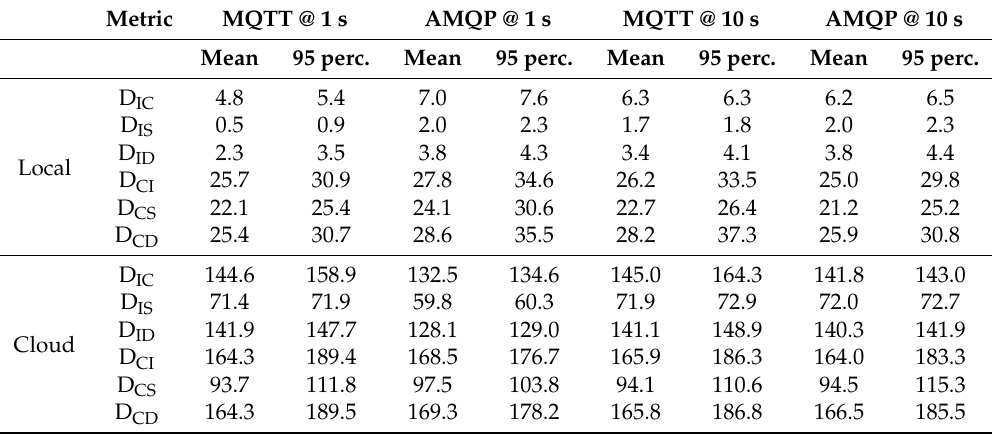
Table 4. Performance metrics of the proposed architecture as implemented for the experiments (ms).